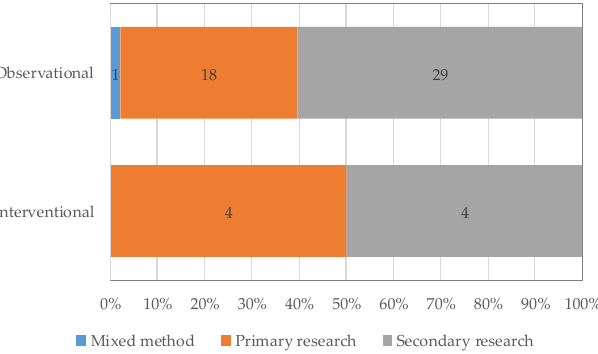
Figure 3. Design of the eligible studies.